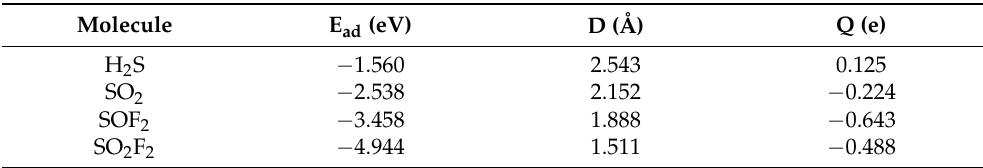
Table 1. Adsorption energy (E ad ), adsorption distance (D), and transferred charge (Q) for the best adsorption configuration of four gas molecules on Mo 2 C. D (Å) is the distance between the gas molecule and the nearest atom of the adsorption substrate; Q (e) is the charge transfer between the gas molecule and the adsorption substrate.